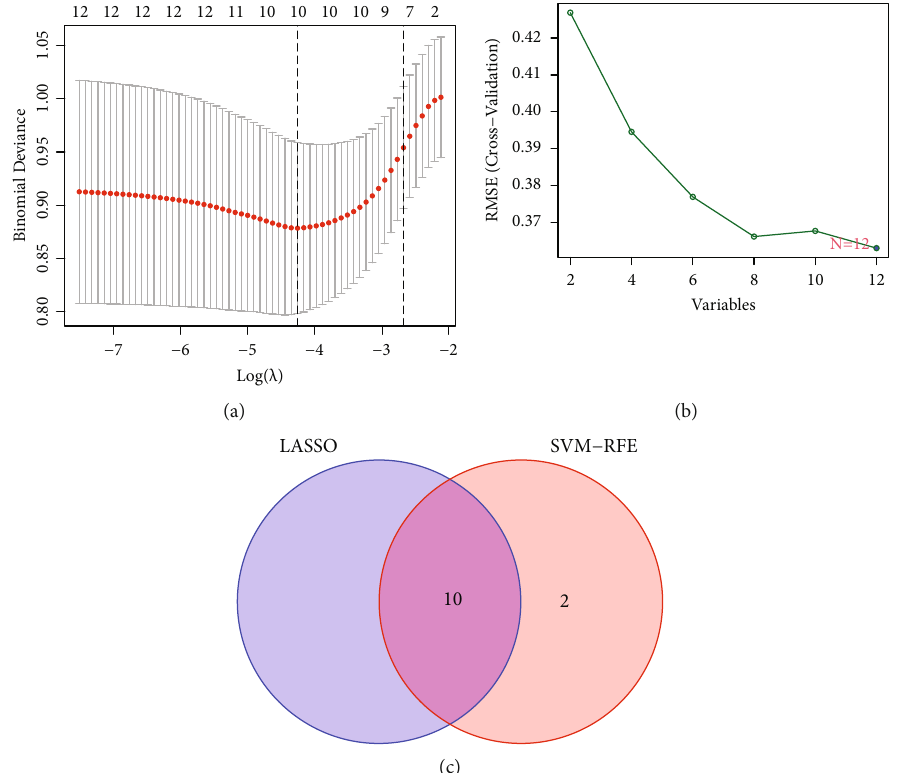
Figure 2: Filtering course of diagnostic candidates of distinguishing PCNSL from glioma. (a) Tuning characteristic option in LASSO model. (b) A plot of biomarkers option through SVM-RFE algorithm. (c) Venn diagram illustrating 4 diagnostic markers shared by LASSO and SVM-RFE